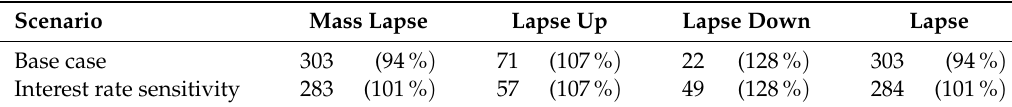
Table 11. Cost-of-capital RM ( ∗ ) (in % of SCR projection) resulting from interpolation of SCRs (in A